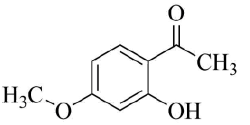
Figure 1. Paeonol chemical